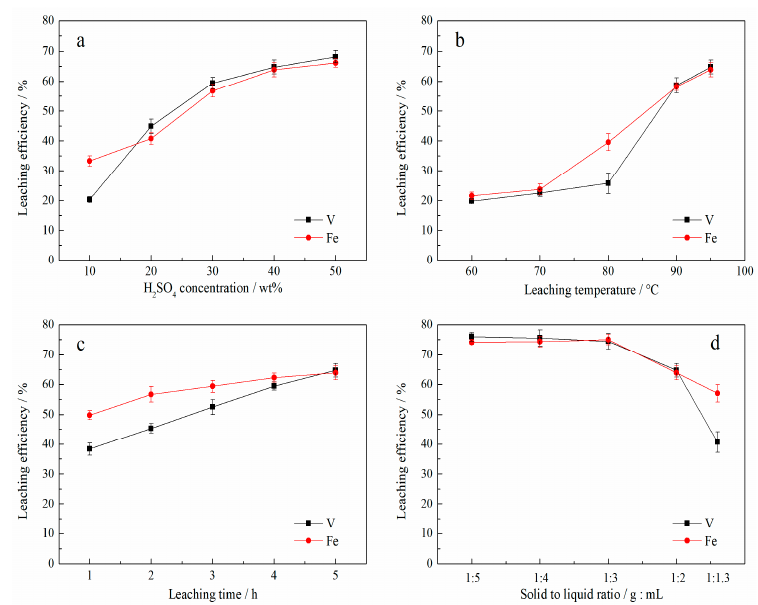
Figure 2. The leaching efficiency of V and Fe from the roasted ore at different leaching conditions. Variables: ( a ) the H 2 SO 4 concentration; ( b ) the leaching temperature; ( c ) the leaching time; ( d ) the solid to liquid ratio.